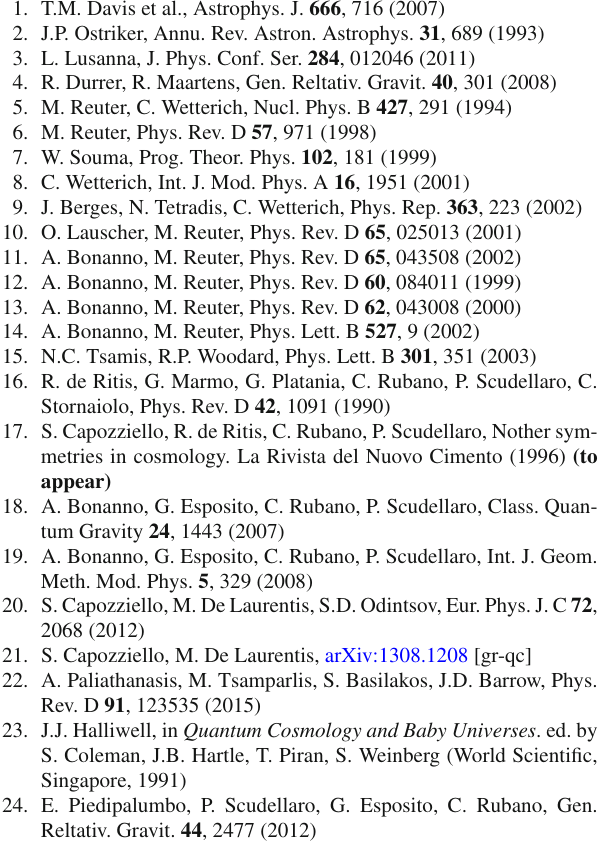
does not exist a fixed point for which G vanishes at small ‘ t ’ and (cid:2) diverges but the product (cid:2) G approaches a